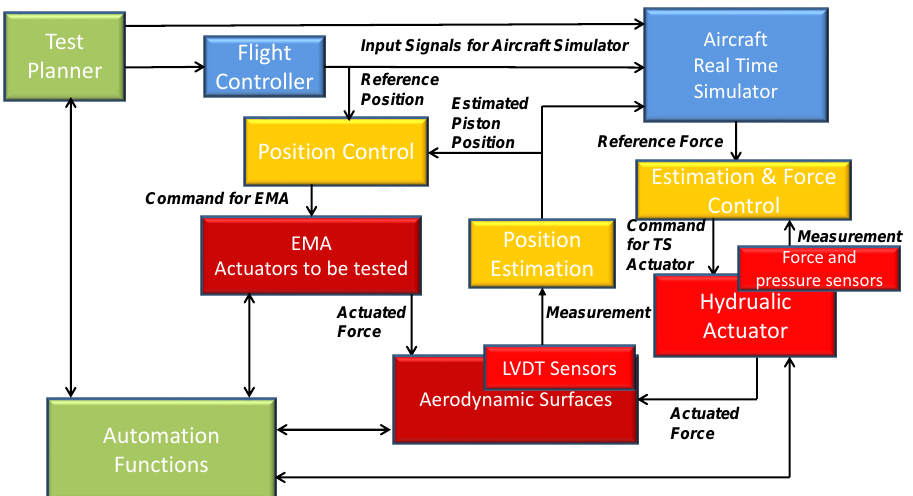
Figure 2. MIB Automation and Control System Architecture. Red, dark red and yellow blocks are replicated for each TS